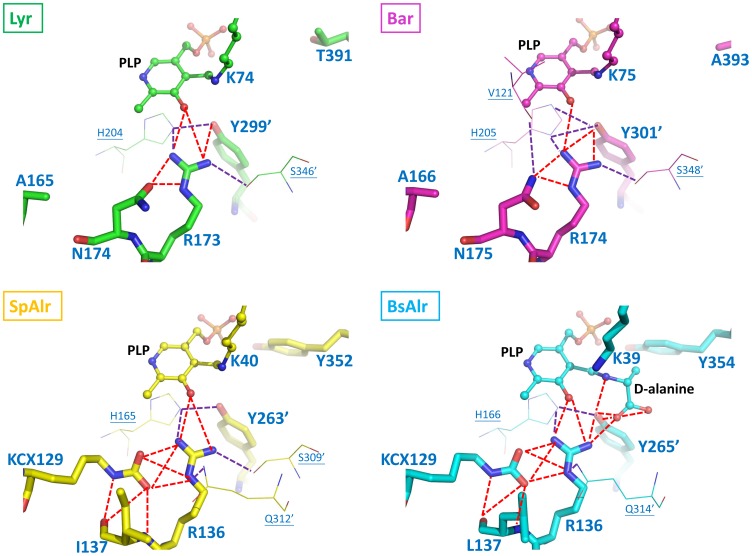
The Hydrogen-bonding Networks in the Binding Pockets of Lyr, Bar, SpAlr, and BsAlr.The carbon atoms of Lyr, Bar, SpAlr, and BsAlr are shown in green, magenta, yellow, and cyan, respectively. The views are those obtained by superpositioning the structures. The aldimine linkages involving PLP and K74 in Lyr, PLP and K75 in Bar, PLP and K40 in SpAlr, and PLP and d-Ala in BsAlr are shown as ball-and-stick models. Protein residues are shown as stick models. Oxygen, nitrogen, and phosphate atoms are colored red, blue, and orange, respectively. The hydrogen bonds between a ligand and the four residues KCX129, R136, L137, and Y265′ in BsAlr are shown as dashed red lines, and other hydrogen bonds are shown as dashed purple lines.